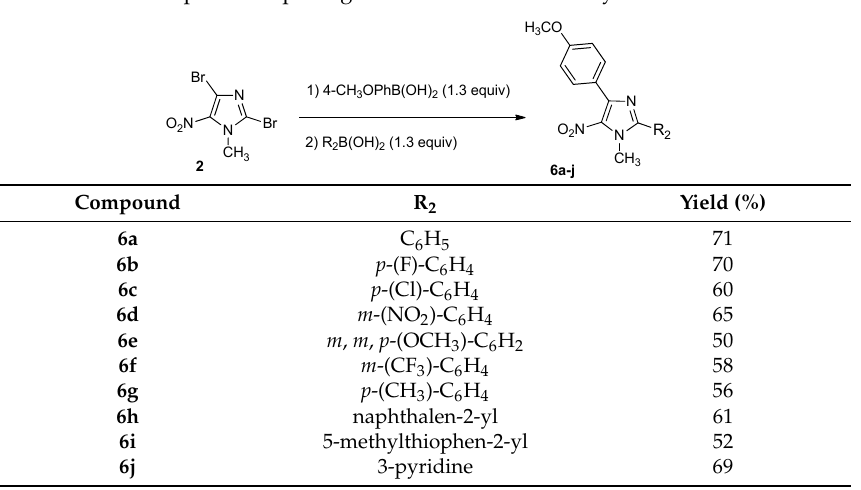
Table 4. Scope of one-pot regioselective bis-Suzuki-Miyaura reaction. a